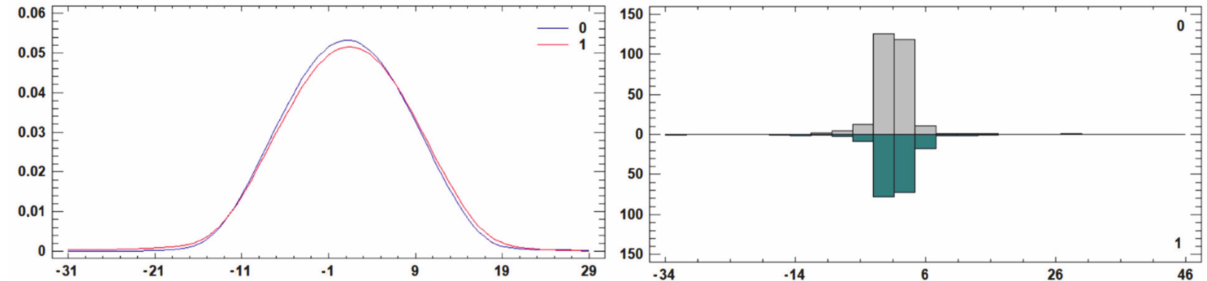
Figure 10. Comparison of the distribution function of results—Bonity index. Legend: 0—agricultural cooperatives, 1—businesses.